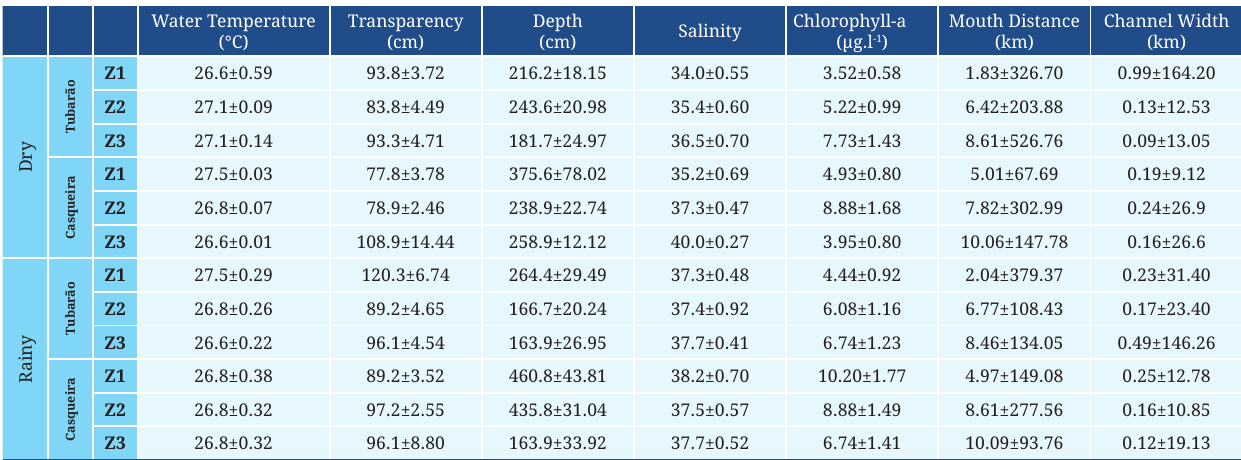
TABLE 1 | Mean values and standard error of environmental parameters (± Standard error) for Tubarão and Casqueira river estuaries, Semiarid Northeastern Brazilian coast (Z1 = Lower; Z2 = Middle; Z3 = Upper). Water Temperature Water Temperature TransparencyTransparency (°C)(°C)